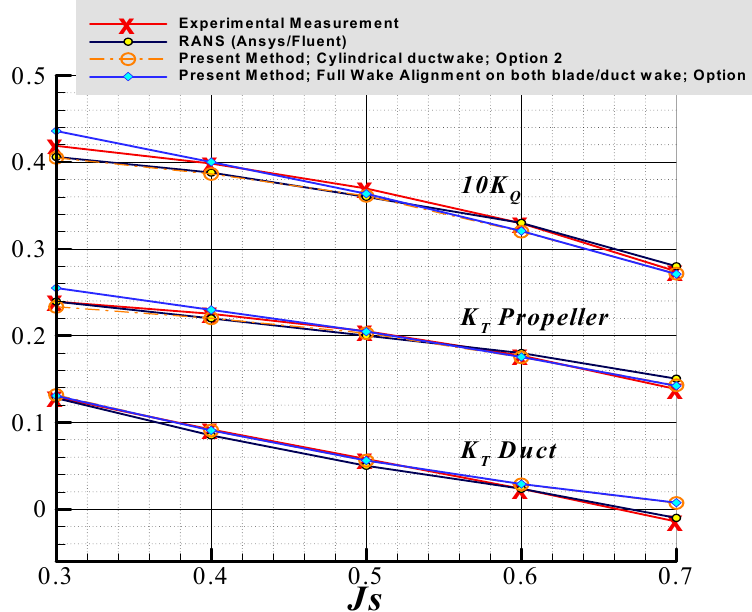
Figure 14. Predicted performance of the KA4-70 ducted propeller by the present method (with cylindrical duct wake and with full wake alignment on duct wake) and RANS, and compared with measured values.